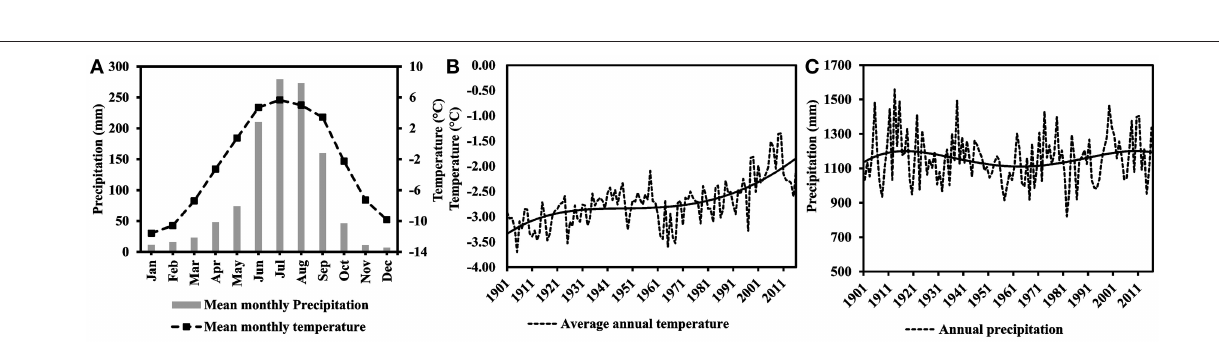
( < 0.003 km 2 ), use of medium-resolution imagery (e.g., 30